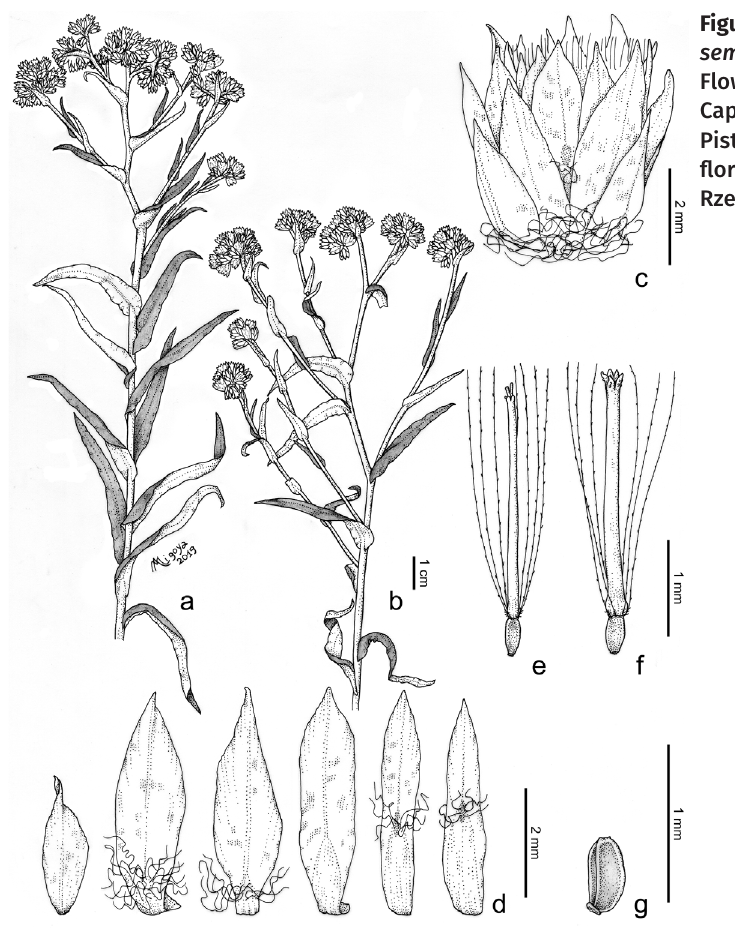
Figure 4. Pseudognaphalium semiamplexicaule. a, b . Flowering branches; c . Capitulum; d . Phyllaries; e . Pistillate floret; f . Bisexual floret; g . Achene [a-g. Rzedowski 36561,